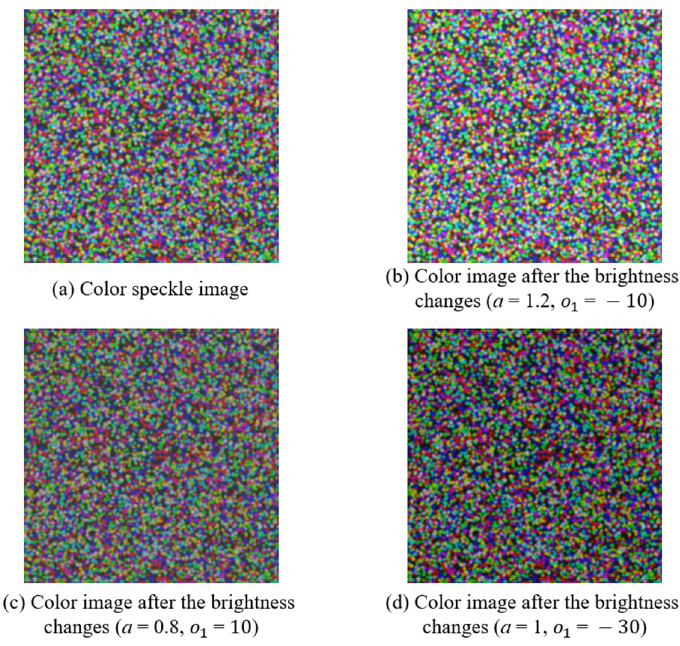
Figure 8. A set of simulated images with different brightness.